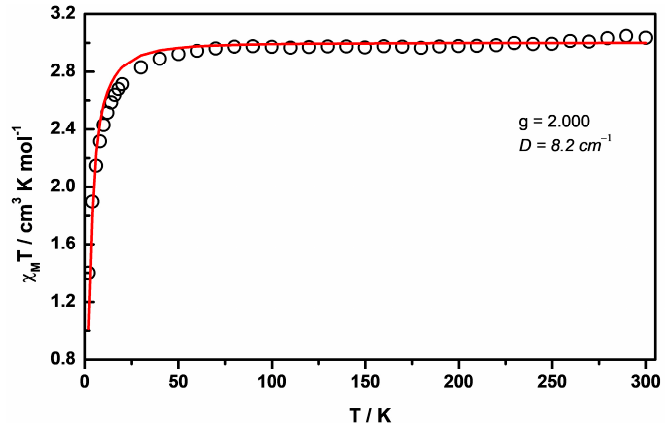
Figure 1. Variable-temperature magnetic susceptibility data for a fine-crystalline sample of [Fe( L H ) 2 ](ClO 4 ) 2 according to the dc -magnetometry. The red line represents the fit. For [Fe( L Br ) 2 ](ClO 4 ) 2 and [Fe( L Me ) 2 ](ClO 4 ) 2 , see Figure S1 of ESI.